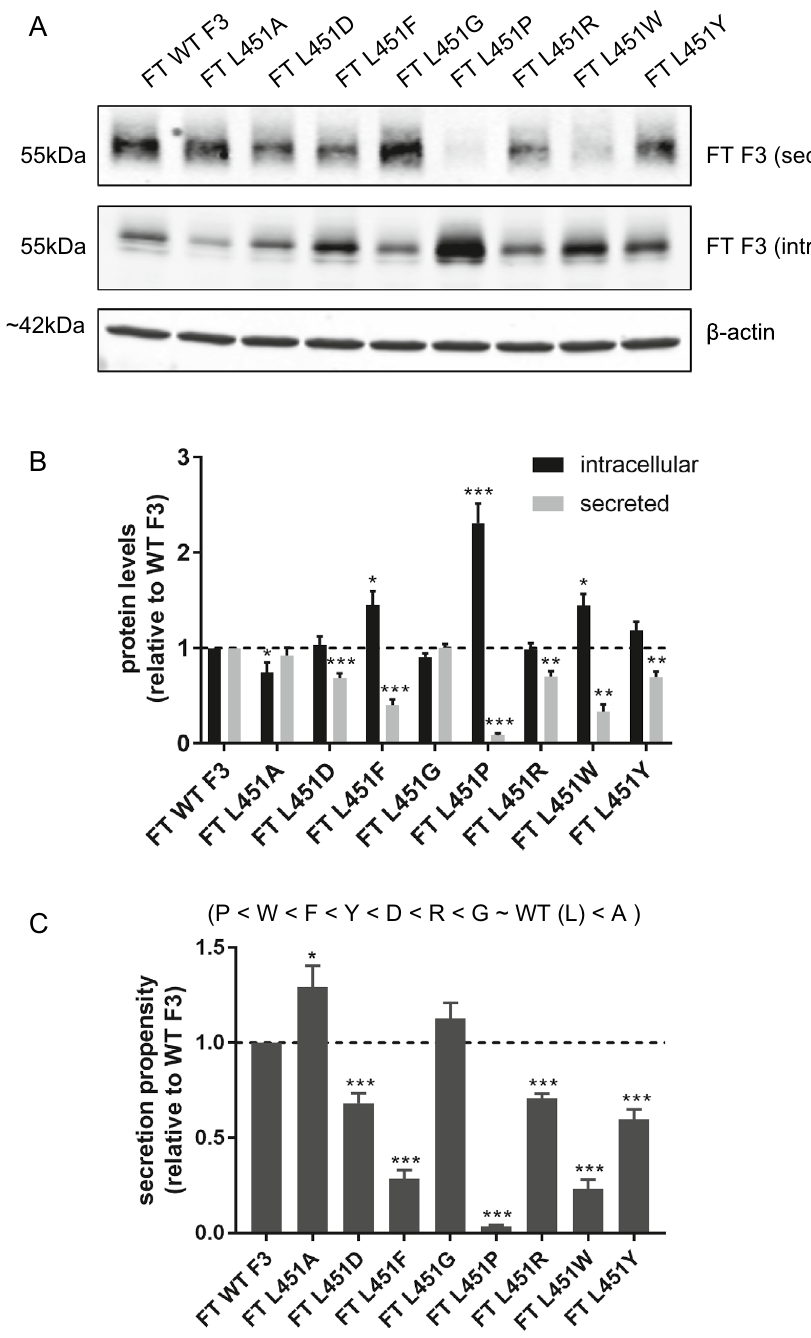
Figure 4. Substitution of leucine at position 451 with select residues. ( A ) Western blot of secreted and intracellular levels of L451F substitution variants. ( B ) Quantification of secreted, intracellular, and ( C ) secretion propensities of L451F substitution variants in ( A ), n ≥ 4, mean ± SEM (* p < 0.05, ** p < 0.01, *** p < 0.001, one sample t test vs. a hypothetical value of 1 [i.e.,